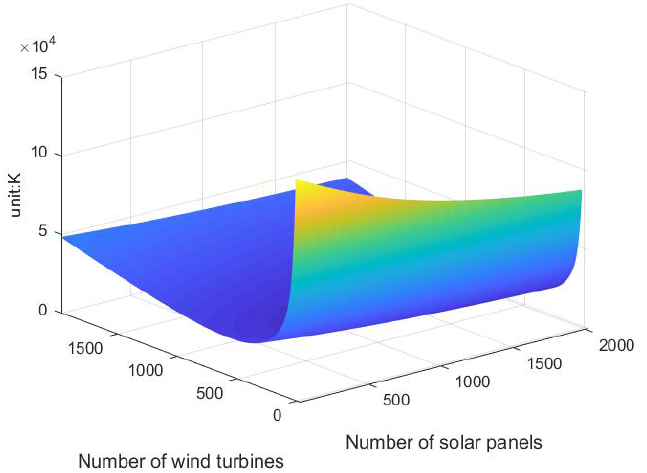
Figure 6. System construction cost model.